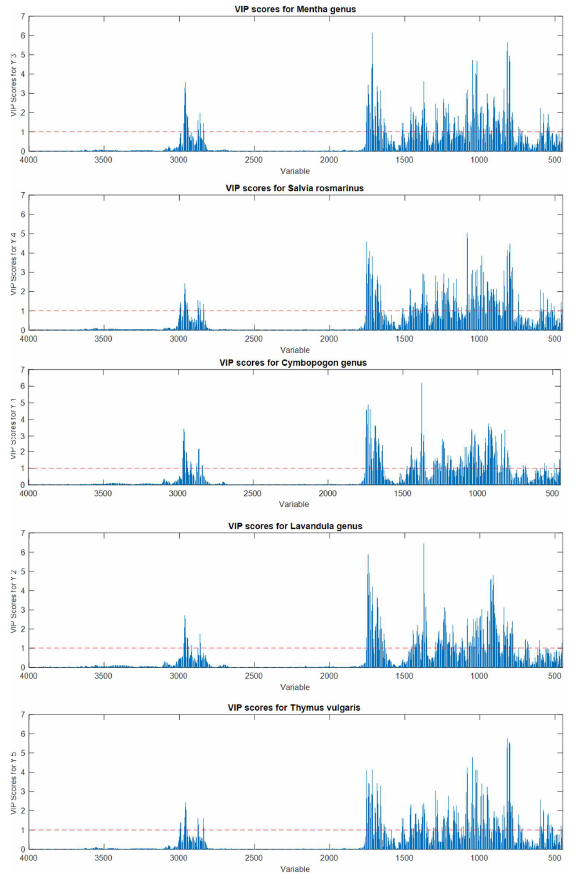
Figure 7. Variable importance on projection (VIP) score plots for the PLS-DA models for discrimi- nating Mentha , S. rosmarinus , Cymbopogon , Lavandula , and T. vulgaris essential oils. Red dotted lines indicate the significance threshold.